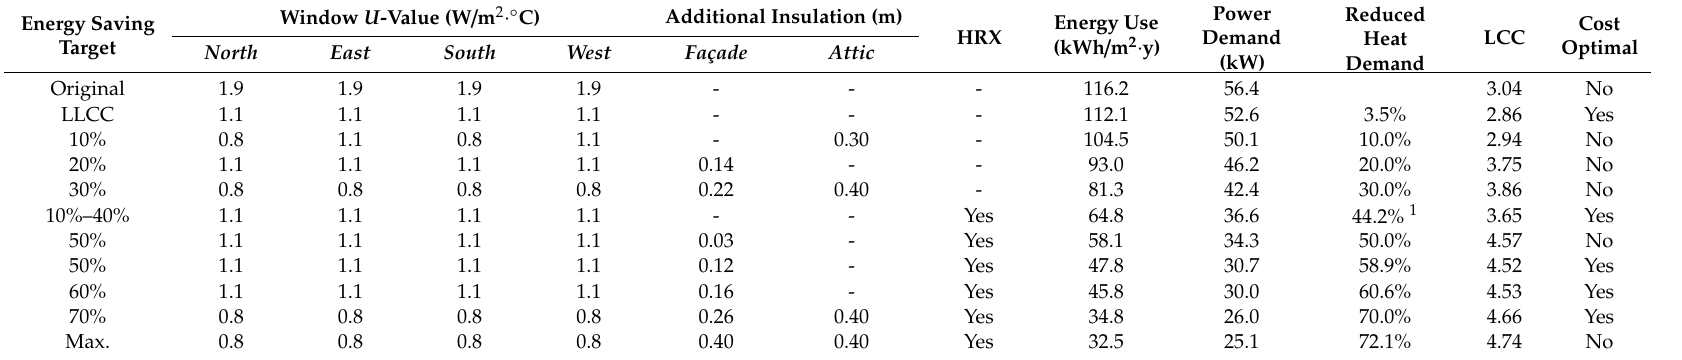
Table 17. EEMs at di ff erent energy saving targets between 10% and 70% for the 1970s